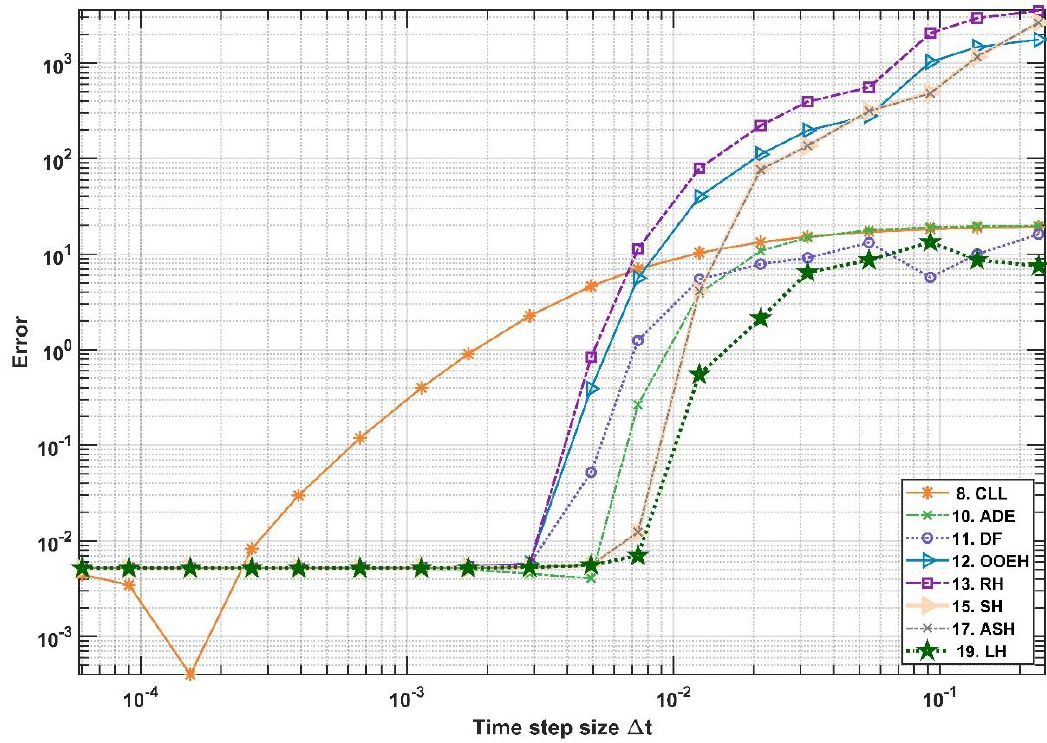
Figure 12. The errors as a function of the time step size for the quickly converging methods, as well as the CLL method, in the case of Experiment 5.